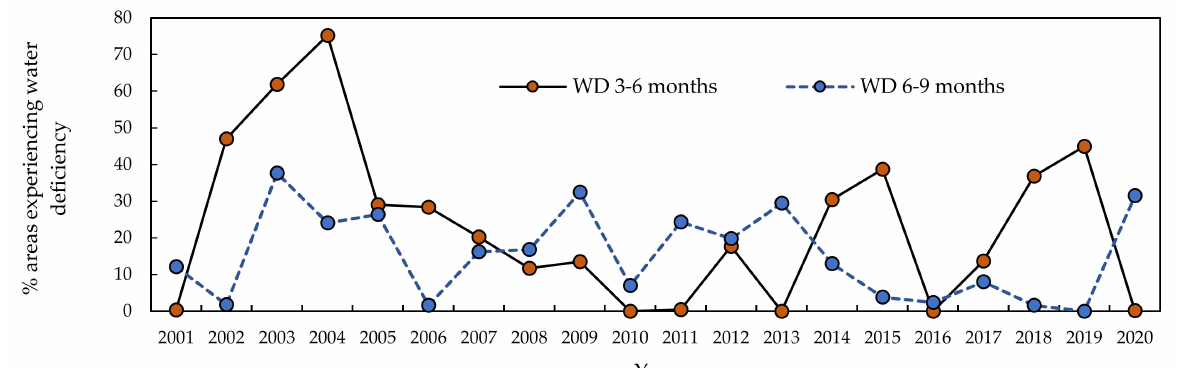
Figure 9. Inter-annual variation of areas experiencing water deficiency in the Brantas watershed from 2001 to 2001 as observed by adjusted ANN-PET and field rainfall